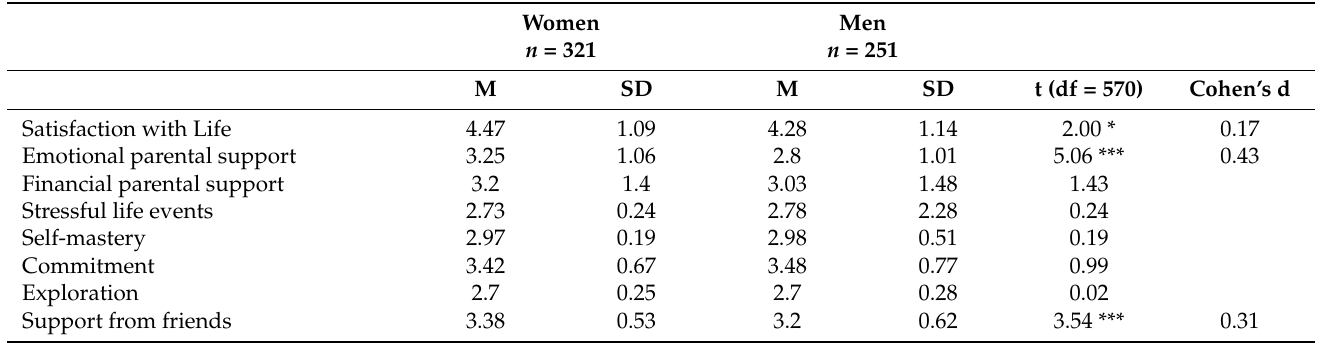
Table 1. Means, Standard Deviations, and t -tests for the Study Variables in the Two Study Groups. Women n = 321